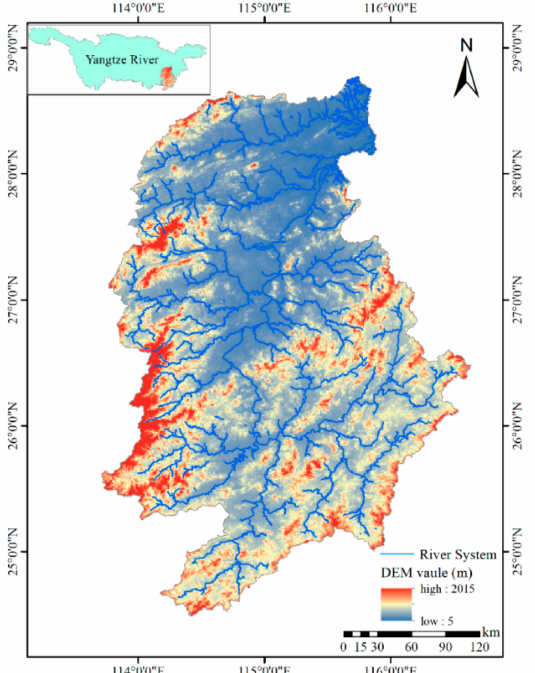
Figure 1. The location of the Ganjiang River Basin and the distribution of river